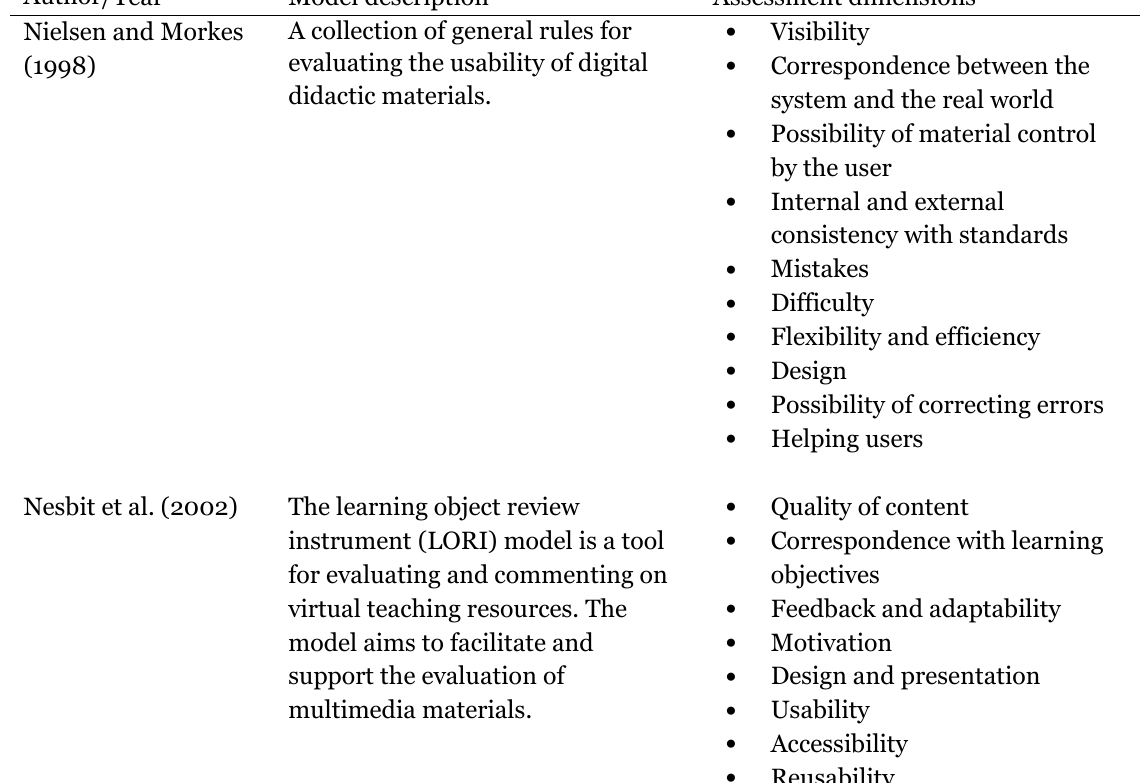
Comparative Analysis of 10 Models Developed to Assess the Quality of Didactic Materials